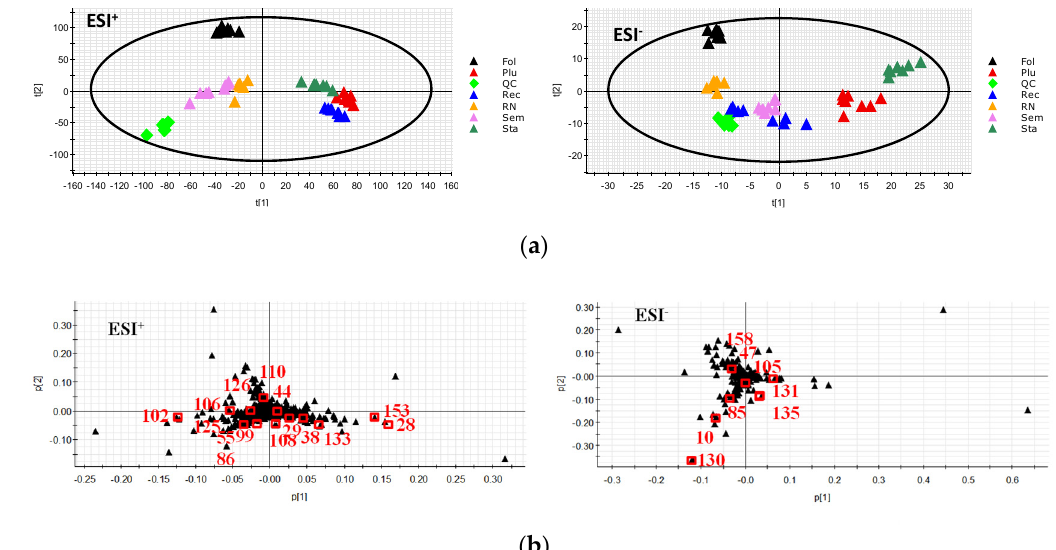
Figure 5. The PCA score plot ( a ) and loading plot ( b ) of six different parts of lotus.